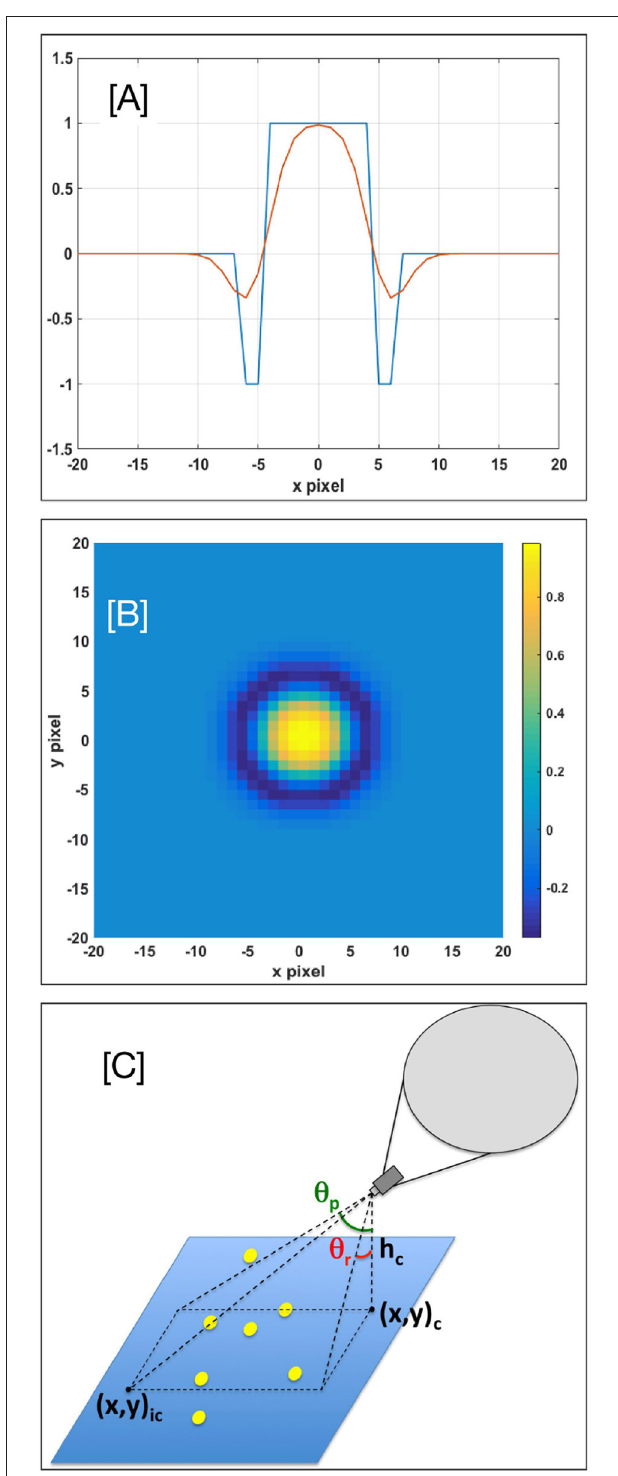
FIGURE 3 | (A) Cross-section of the kernel along the x-axis showing the step function in blue and the Gaussian smoothed shape in red. (B) Kernel of the shape filter used to identify individual bamboo plates. (C) Schematic diagram of the relevant quantities used to rectify STARSS imagery. Here, θ p , θ r , h c ,( x , y ) c ,, and ( x , y ) ic correspond to pitch, roll, heading, altitude, camera position, and image center, respectively. See Equation 6 in section